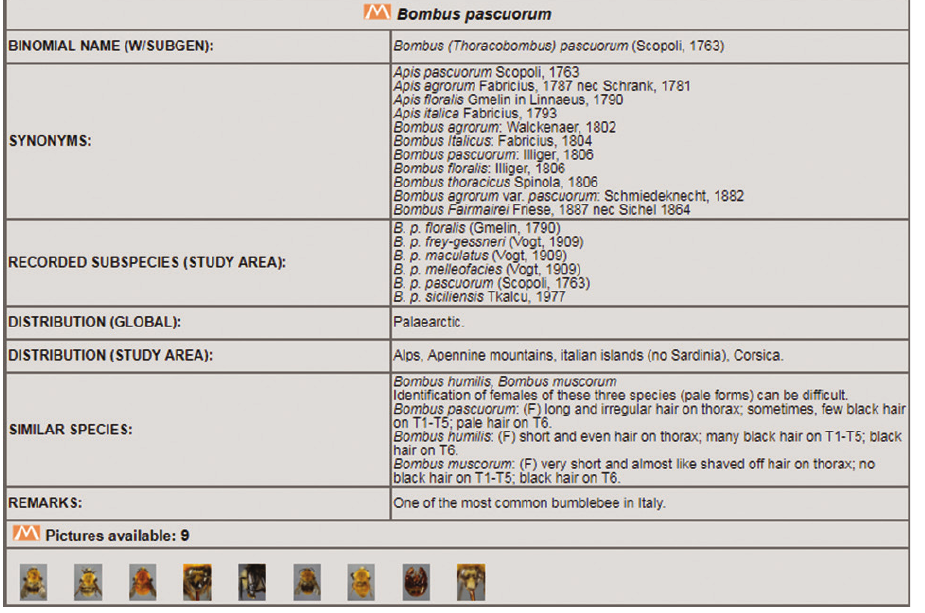
Figure 4. Example of taxon